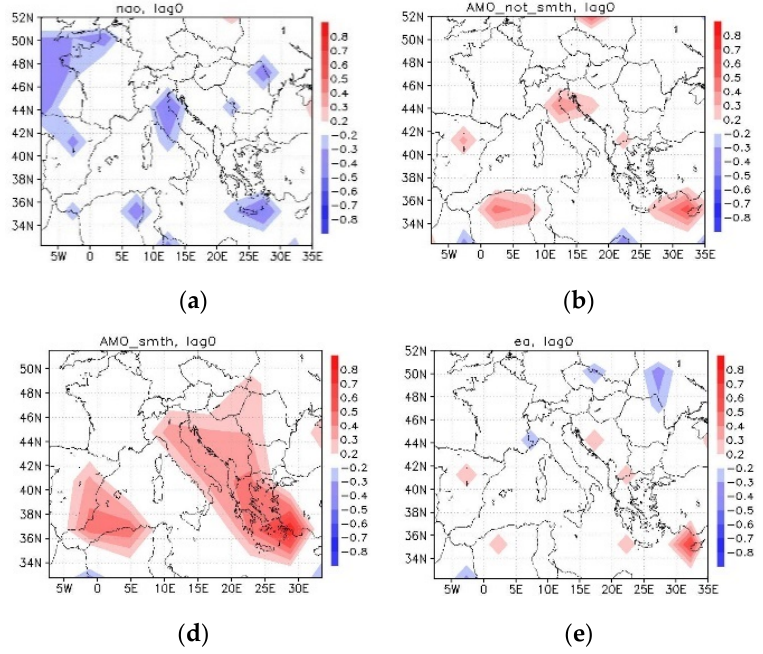
Figure 12. As in Figure 11, for summer (AMJJAS). The modes are: NAO ( a ), AMO ( b ), AMOs ( c ) and EA ( d ).